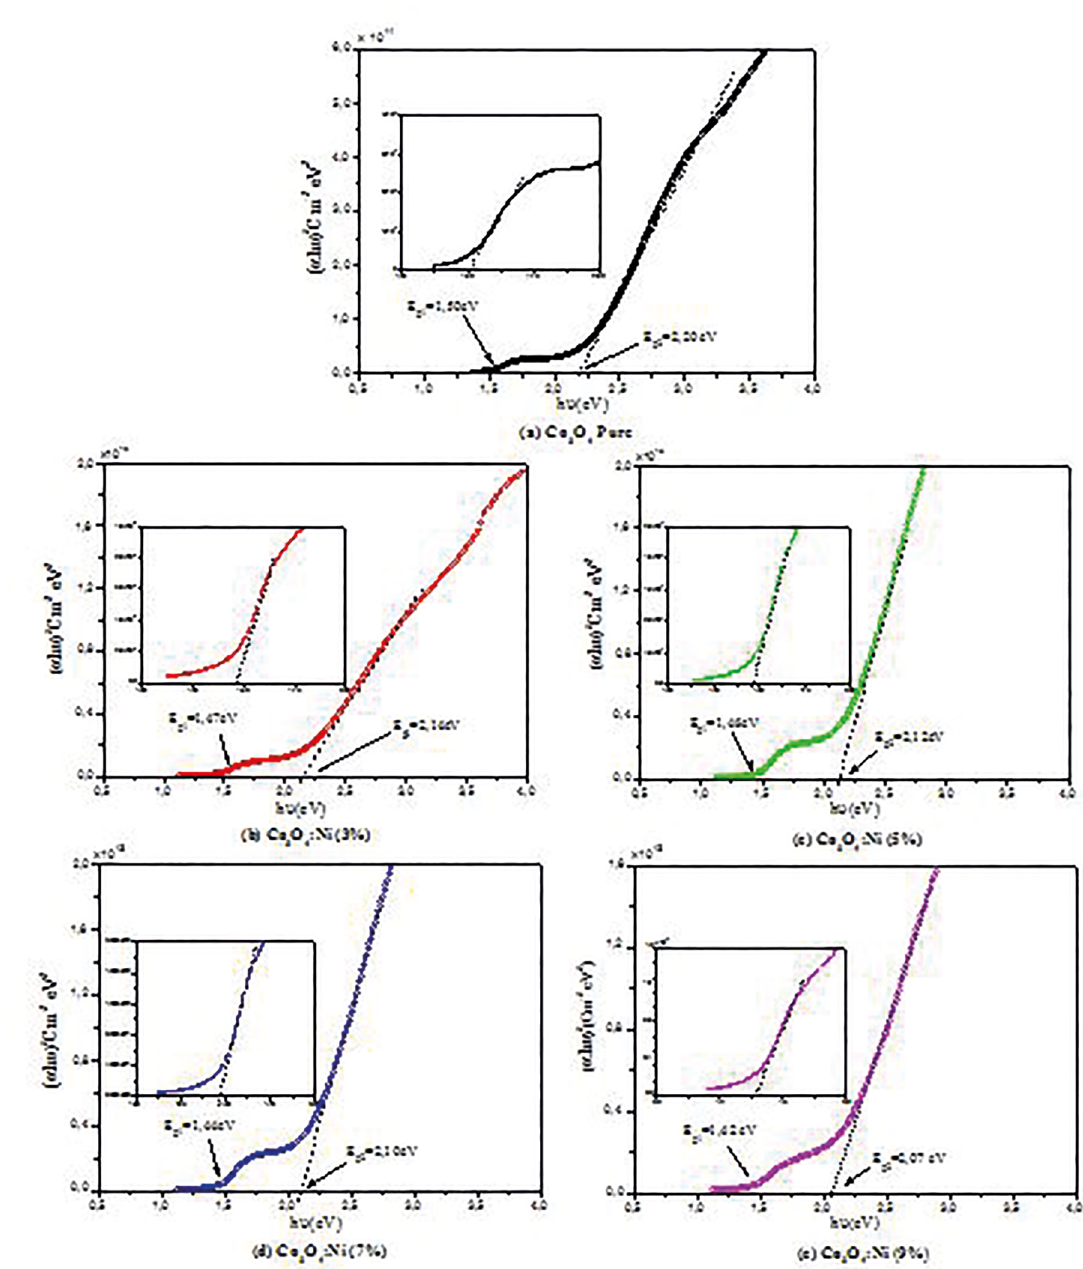
O films at different doping levels 3 4